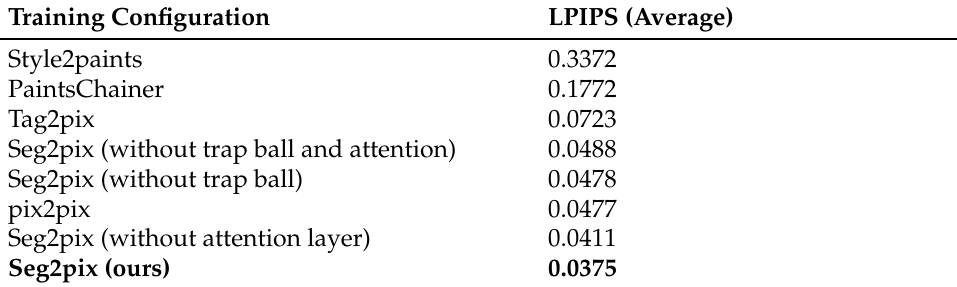
Table 2. Results of the Learned Perceptual Image Patch Similarity (LPIPS) in our experiments showing a better score compared to the other colorization models, even against Pix2pix, which was trained on the same dataset as